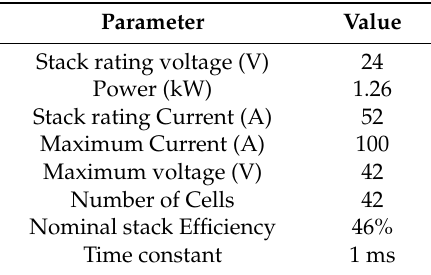
Table 1. PEMFC Electrical Parameters.